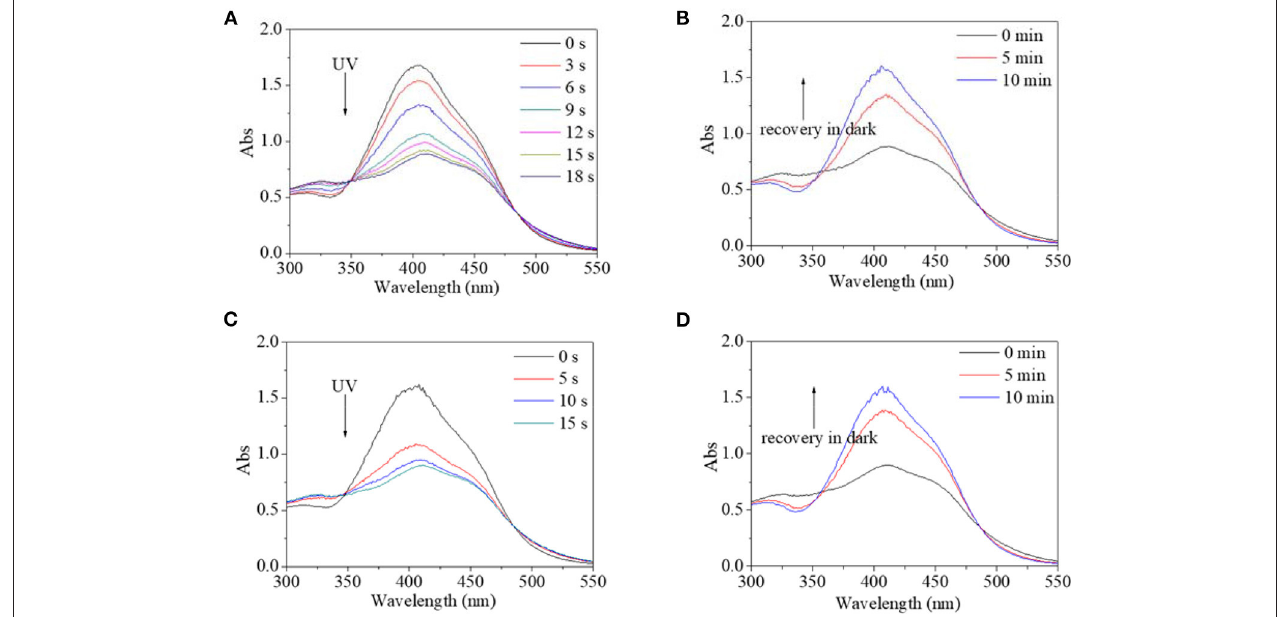
FIGURE 10 | UV spectra of PBLG2 solution with 5% water (A,B) and 10% water (C,D) as a function of irradiation time (A,C) and recovery time (B,D) . Irradiation was performed under UV light, and recovery process was performed under darkness and room temperature. Polymer concentration was 0.87 mg/mL for (A,B) , 0.83 mg/mL for (C,D) .